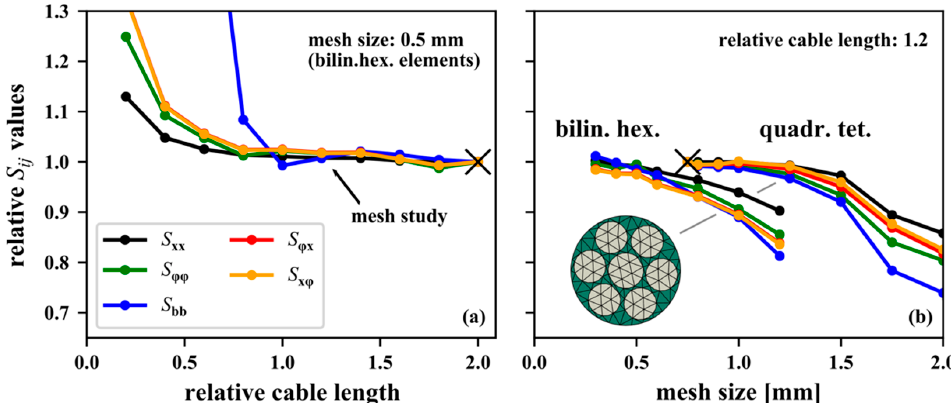
Figure 7. Relative stiffness components of the strand model with ( a ) varied cable length using bilinear hexahedral elements with a mesh size of 0.5 mm and ( b ) varied mesh size with both bilinear hexahedral and quadratic tetrahedral elements for a relative cable length of 1.2.